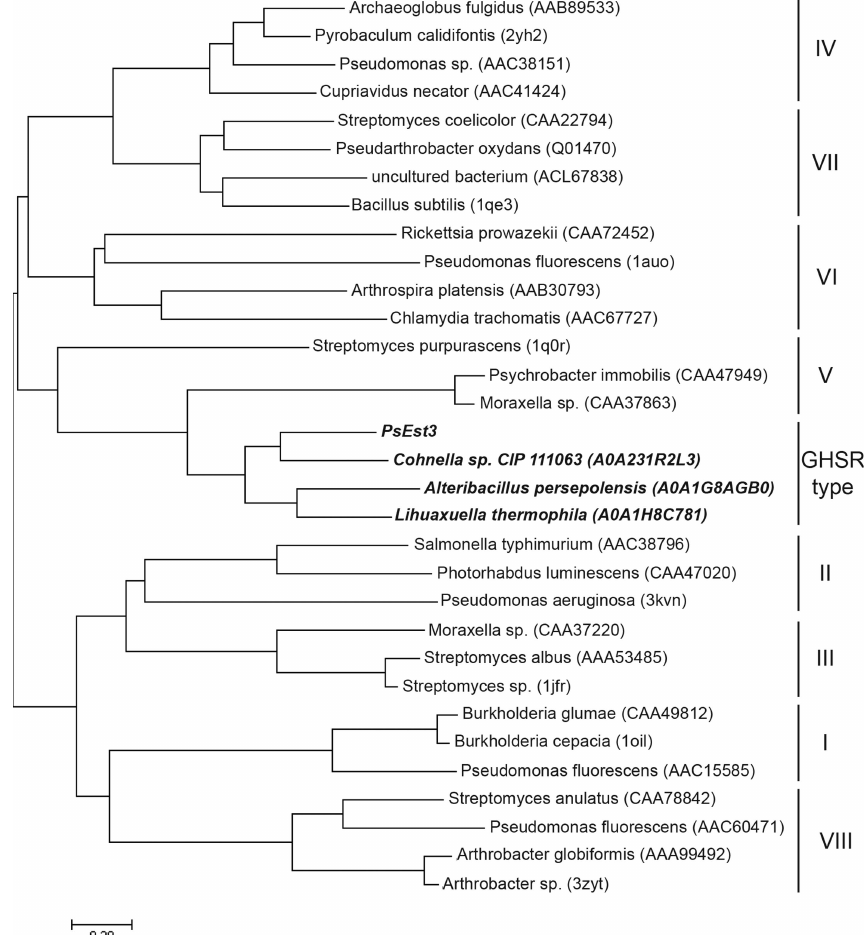
Figure 4 Phylogenetic tree of PsEst3 with lipases/esterases of other classes. The evolutionary history was inferred using the neighbor-joining method based on the amino-acid sequence of PsEst3. The lipase/ esterase enzymes previously classified into classes I–VIII were used as input together with PsEst3 and three other homologs (UniProt accession Nos. A0A231R2L3, A0A1G8E3W4 and A0A1H8C781). Evolutionary analyses were conducted in MEGA 7. The tree is drawn to scale, with branch lengths in the same units as those of the evolutionary distances used to infer the phylogenetic tree. GenBank, UniProt or PDB accession codes of the reference sequences are shown in